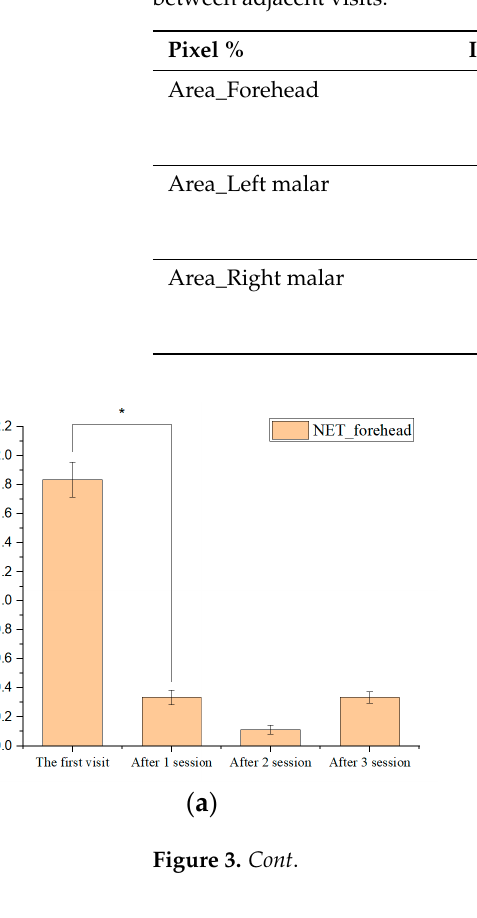
Table 5. Mean difference of pixel % (summation of the area exceeding the erythema threshold) between adjacent visits.